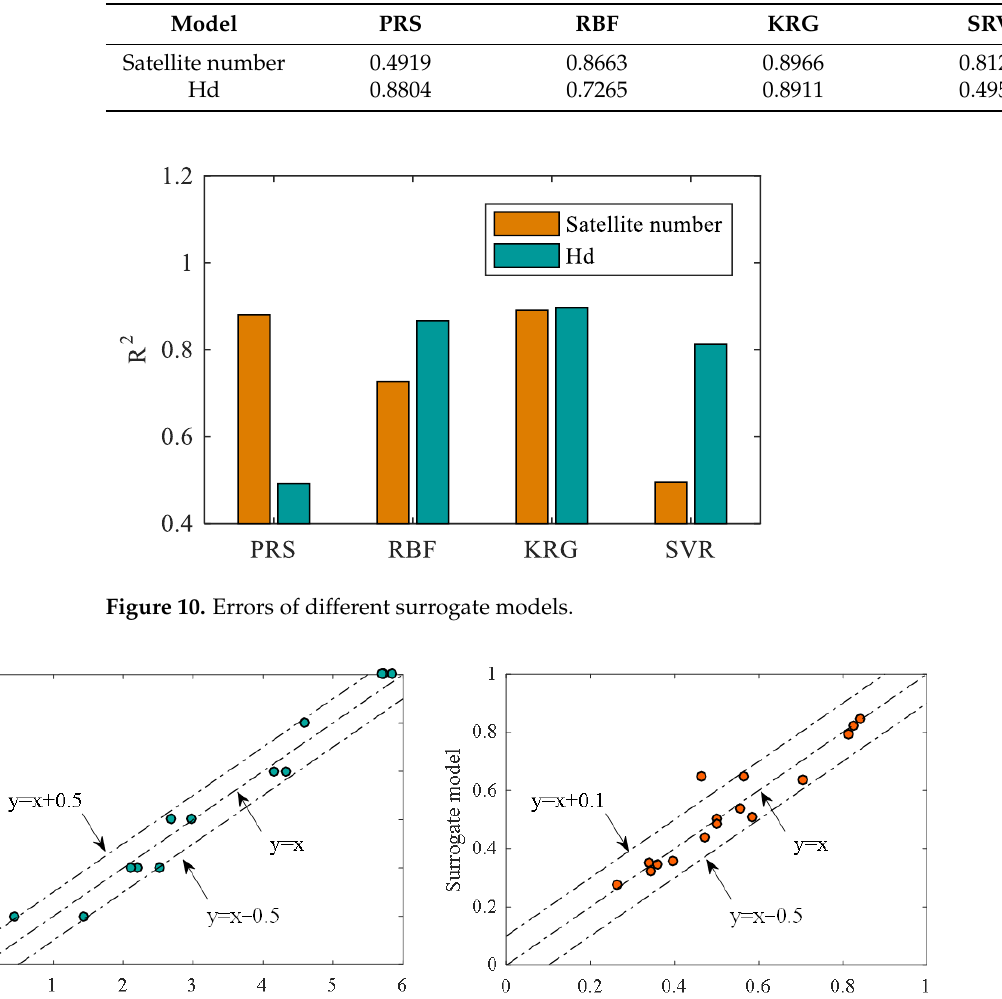
Table 4. R 2 of different surrogate models.